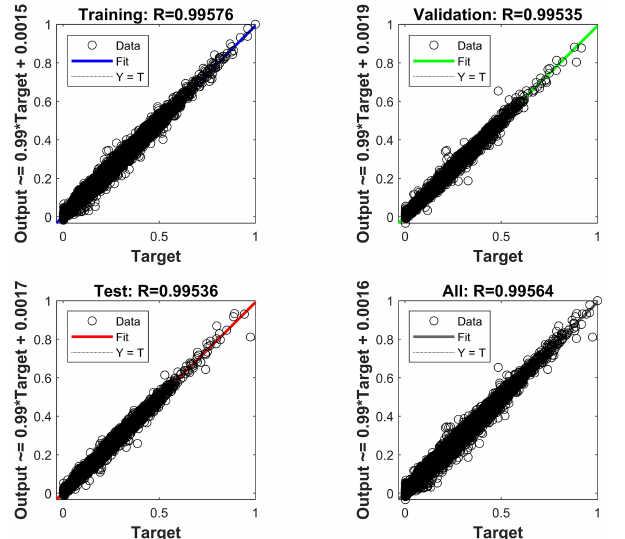
Figure 4. Linear regressions between the normalized neural net- work prediction and the measured DELs. The NN is built using the complete dataset (i.e. 8 months) and 27 features selected after the Pearson correlation